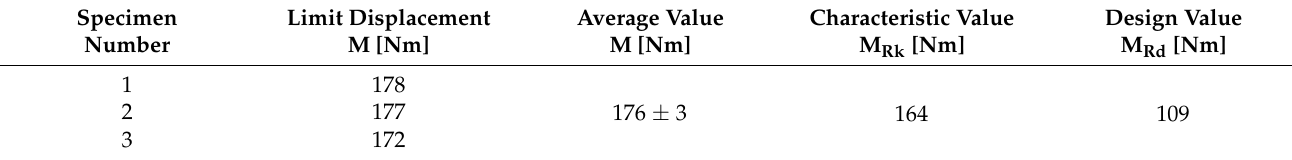
Table 3. Characteristic and design values for opening of the rigid